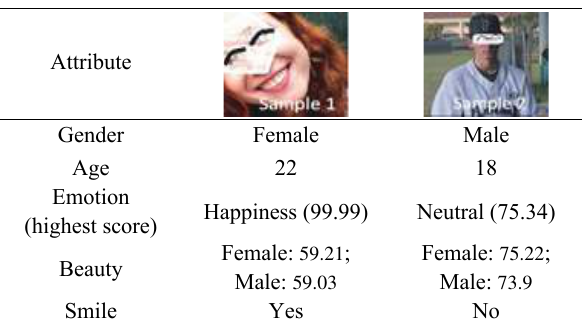
Table 1 Examples of the face attributes.